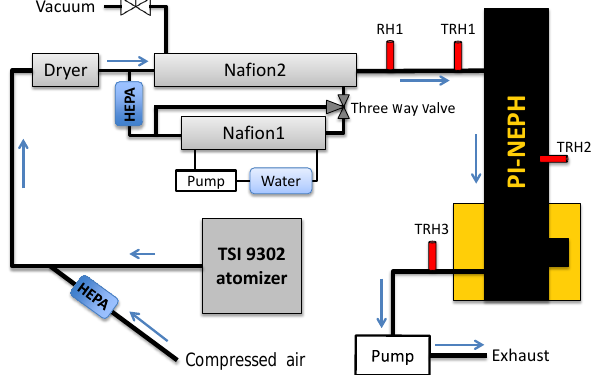
Figure 2. Laboratory aerosol generation instrumental setup used to suspend salts and PSL